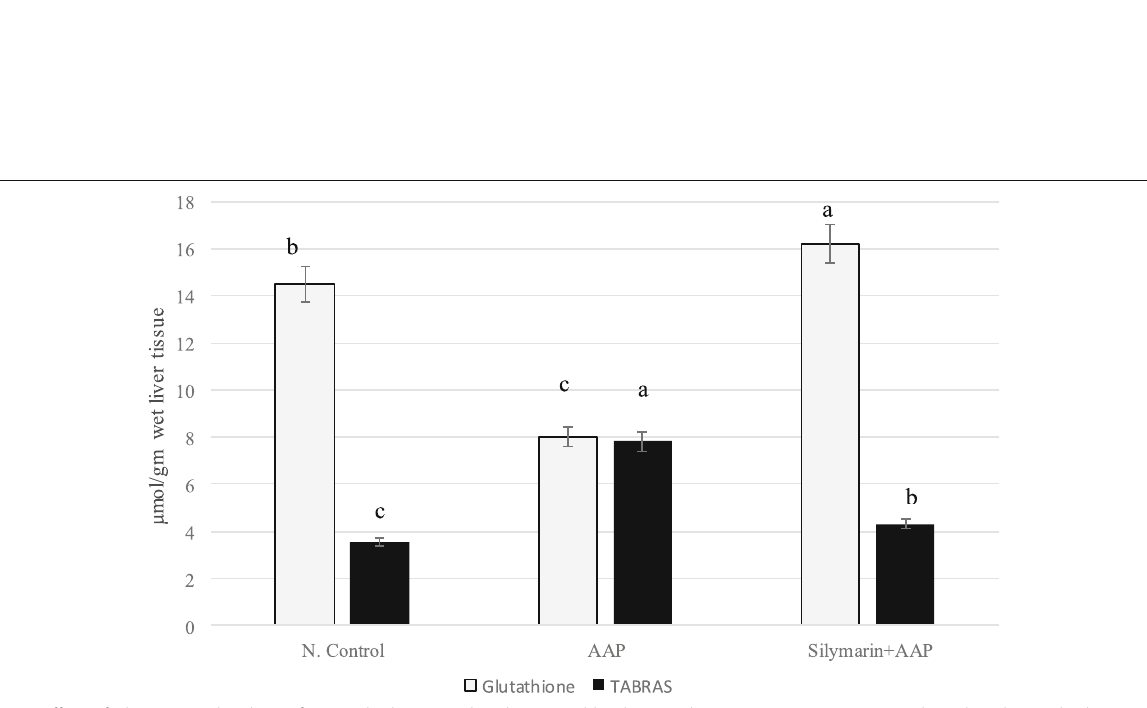
Fig. 2 Effect of silymarin at the dose of 50 mg/kg b.w., on glutathione and lipid peroxidation (TBARS) in acetaminophen dosed rats. The bars in the graph showing mean ± Standard error ( n = 6). The values bearing the same superscript on bar are not significantly ( p < 0.05) different according to Duncan ’ s multiple range test. N. Control = Normal Control; AAP = Acetaminophen; SM =